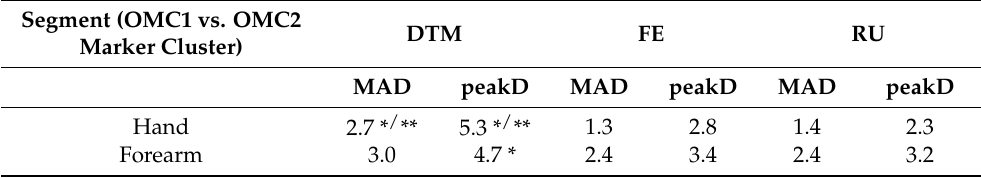
Table 4. Mean absolute difference (MAD) and peak change in centroid distance (peakD) between Table 1 and OMC2 marker clusters during different tasks: dart throwing motion (DTM), flexion– extension (FE), and radial–ulnar deviation